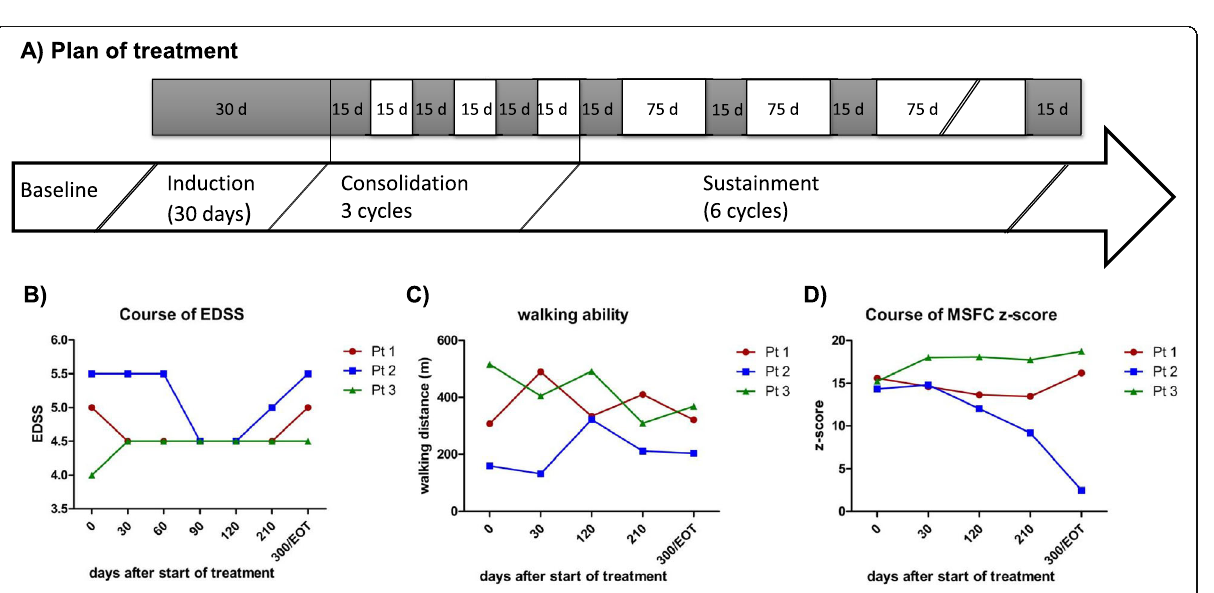
Fig. 1 Schematic overview of treatment plan and clinical outcome. a Schematic overview of the planned treatment, consisting of 30days of induction therapy followed by 3cycles of consolidation therapy and 6cycles of sustainment therapy. Due to lack of evidence and potential aggravation of disease activity, treatment was stopped after the 2nd cycle of sustainment / day 300. b Clinical course of EDSS and c clinical course of walking ability. Slight non-significant improvement was observed on day 210 that was not statistically significant and could not be proven on day 300. d MSFC z score did not show significant changes. All tests showed no significance ( p <0,05) in Friedman-test with Dunn ’ s post-hoc